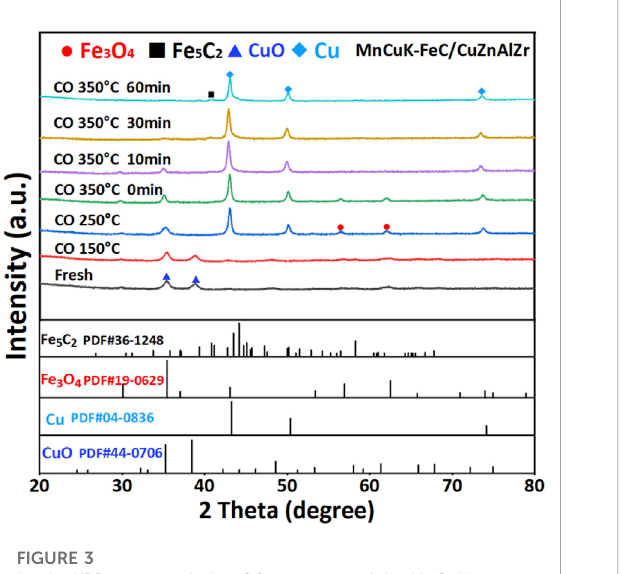
FIGURE 3 In-situ XRD patterns during CO treatment of the MnCuK- FeC/CuZnAlZr catalyst.